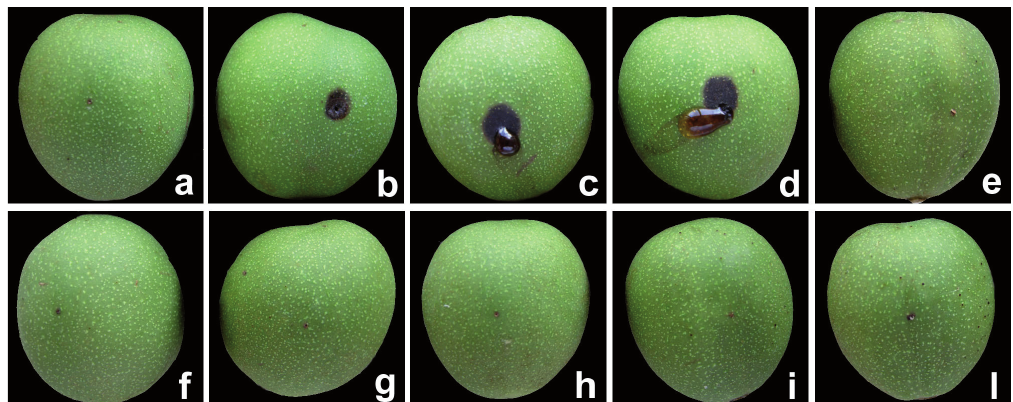
Figure 2. Symptoms on immature walnut fruits inoculated with bacterial suspensions (10 8 cells mL -1 ) of Brenneria nigrifluens DAPP-PG 509 (b), B. nigrifluens DAPP-PG 621 (c), B. nigrifluens LMG 2694 T (d), Dickeya chrysanthemi DAPP-PG 637 (e), Erwinia rhapontici DAPP-PG 636 (f), Ralstonia pickettii DAPP-PG 640 (g), Spingobacterium spiri - tovorum DAPP-PG 639 (h), an unknown enterobacteriacea DAPP-PG 638 (i), and B. alni CFBP 3923 (l) using the syringe with needle technique, 8 days after inoculation. (a) Control fruit infiltrated with